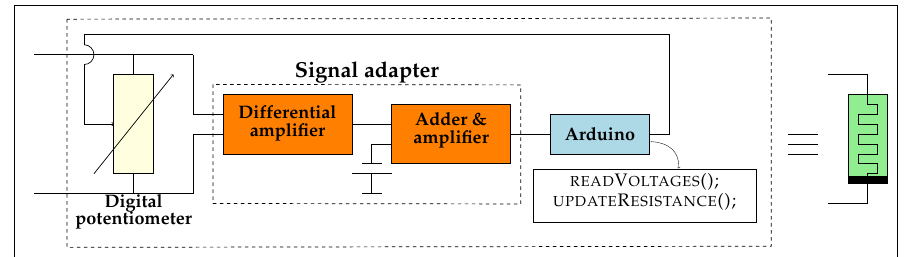
Figure 2. Schematic of the proposed emulator. An analog-to-digital converter (ADC) in the microcontroller measures the voltage on the digital potentiometer. The differential equations describing the memristor behavior are numerically integrated based on those measurements; then, the potentiometer resistance is changed accordingly. Signal conditioning is required to adapt the voltage to the microcontroller ADC input